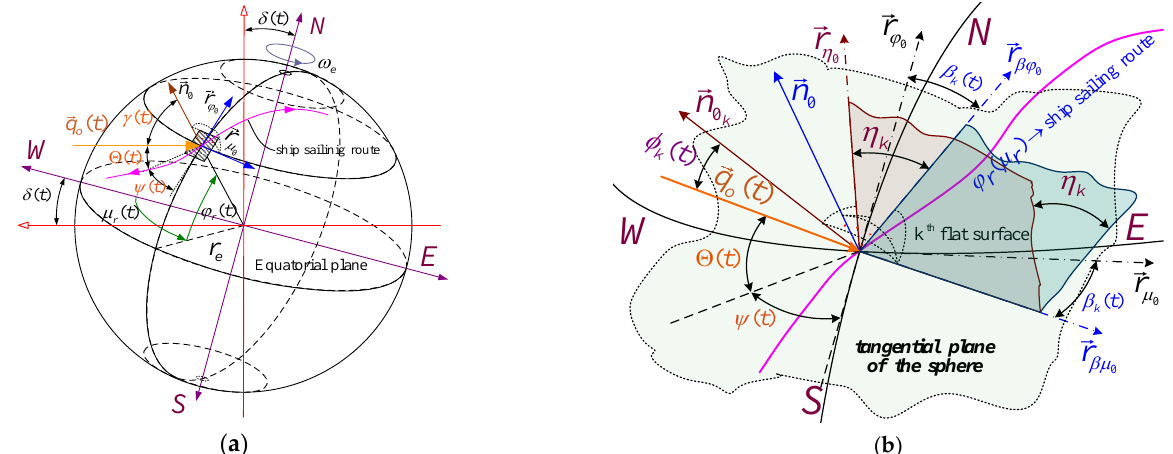
Figure 11. Main parameters of the solar geometry on the sailing route; ( a ) for tangential sphere surface and ( b ) for arbitrary place k th ship’s flat surface .